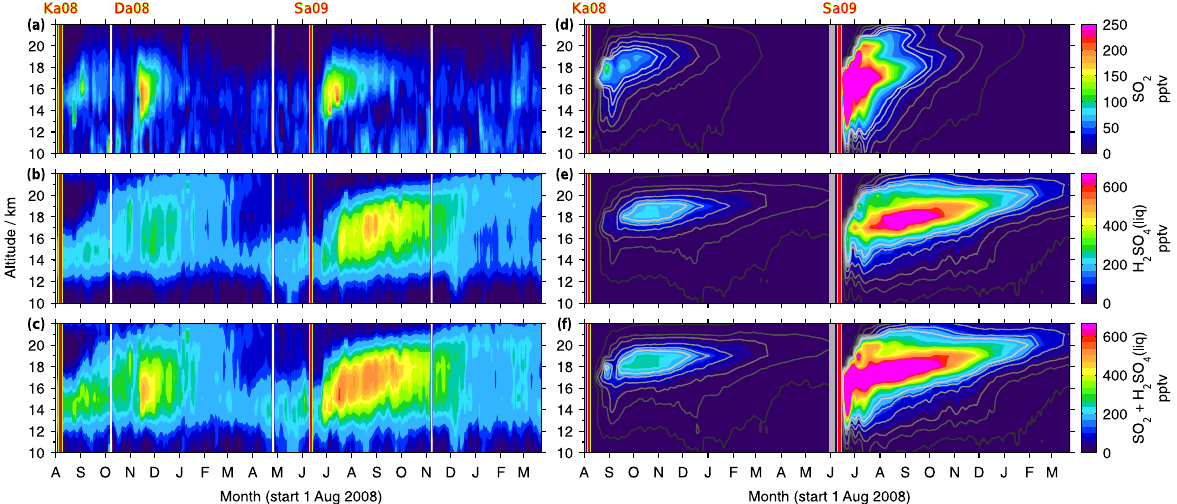
Figure 8. As Fig. 7 but for 0–30 ◦ N. The colour scales are restricted to 0–200pptv (SO 2 ) and 0–800pptv (sulfate aerosol and the sum of SO 2 , and H 2 SO 4 (liq)). Additionally the volcano Dalaffilla is indicated in November 2008, as it was observed by MIPAS. It is not included in the